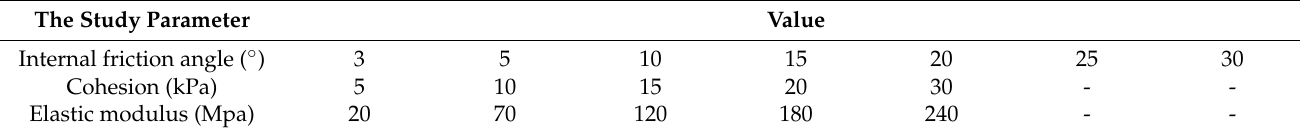
Table 11. Different grouser types and value setting.